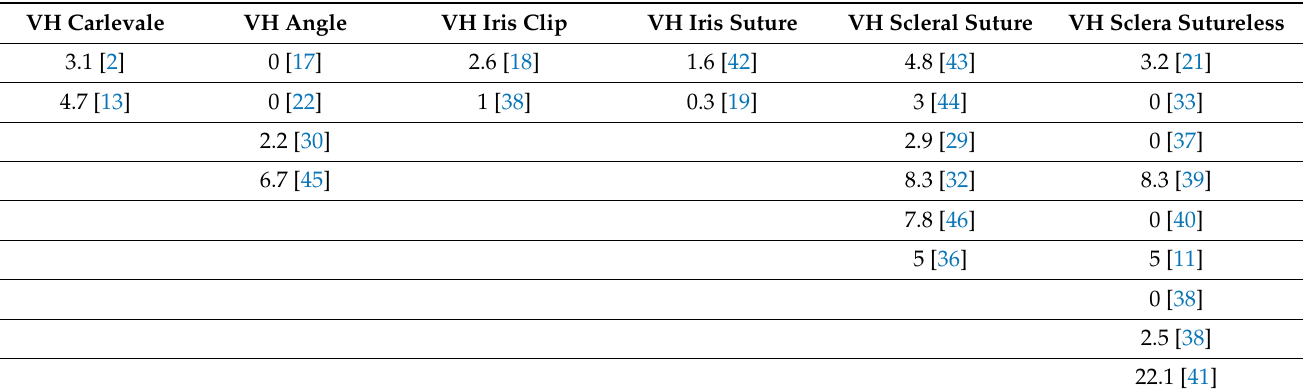
Table 5. Vitreous hemorrhage incidence of complications of different implants.